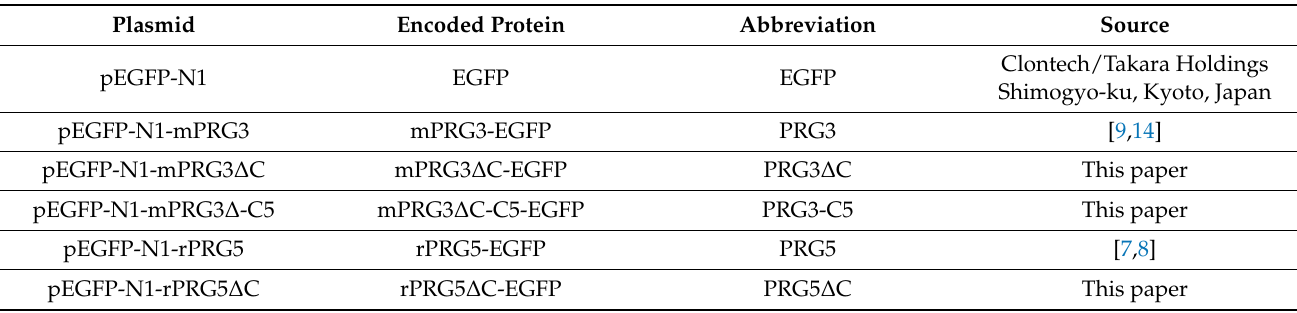
Table 5. Plasmids and fusion proteins